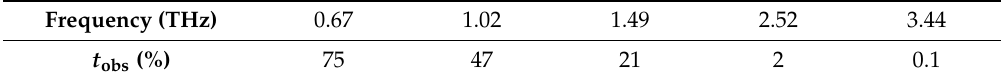
Table 3. Transmission coefficient through an obstacle of light cotton cloth